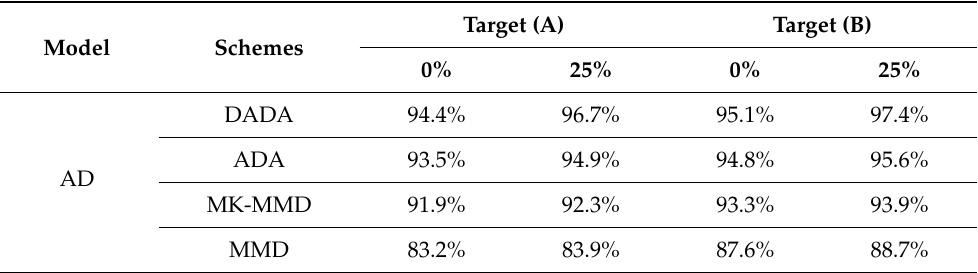
Table 5. Recognition accuracy (RA) without data augmentation.